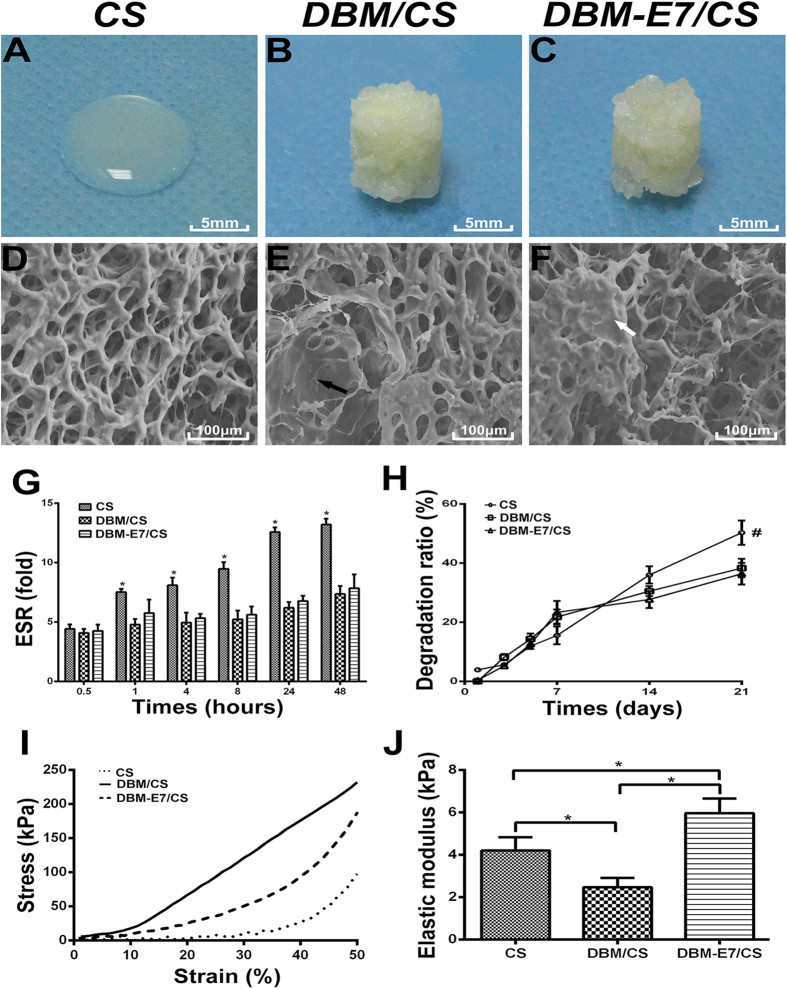
Characterization of the three different structural scaffolds.(A–C) Gross morphologies of CS, DBM/CS, and DBM-E7/CS scaffolds. (D–F) SEM images of the three scaffold groups (black arrow: DBM particles; white arrow: DBM-E7 particles). (G) ESR of the three scaffold groups (n = 5, *p < 0.05). (H) Degradation ratio of the three scaffold groups (n = 5, *p < 0.05). (I) Stress–strain curves of the three scaffold groups (n = 3, *p < 0.05). (J) Elastic modulus of the three scaffold groups (n = 3, *p < 0.05).